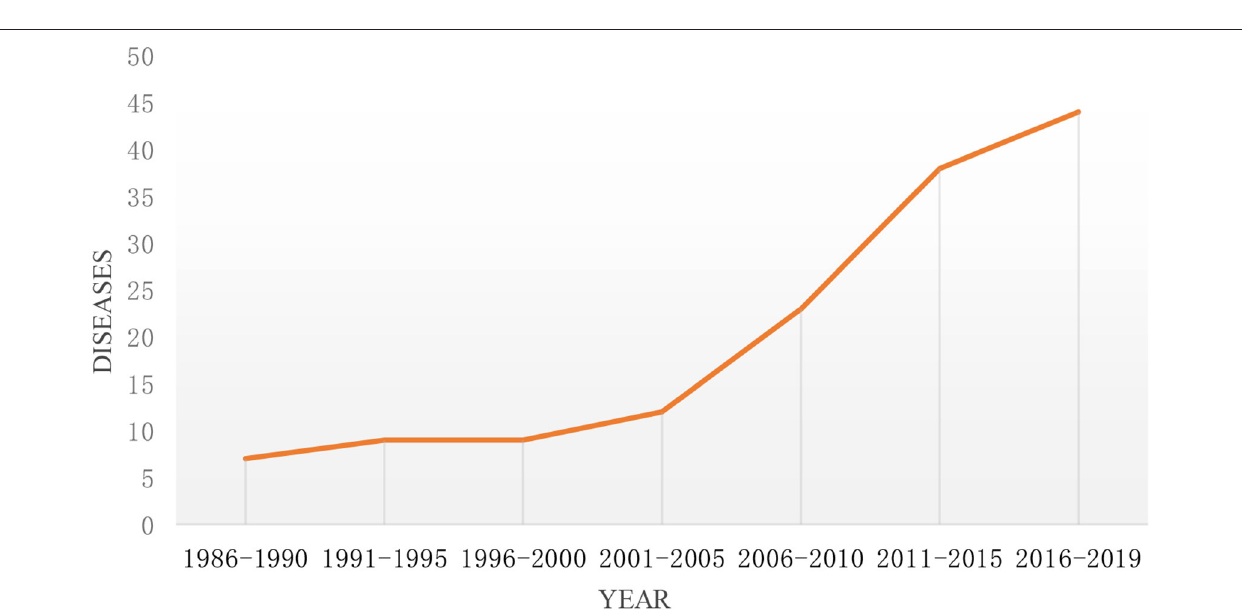
FIGURE 3 | The trend of the types of rare diseases funded by NSFC and its change every 5 years from 1986 to